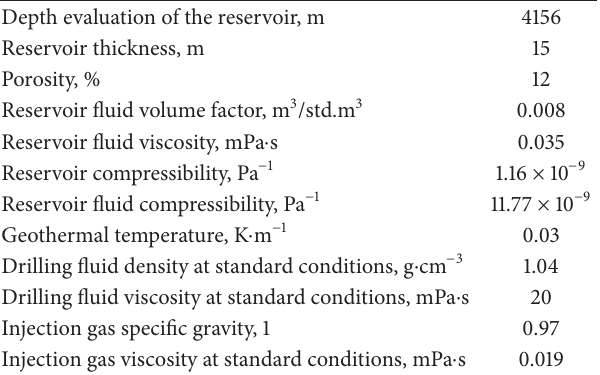
Table 1: Basic parameters for reservoir and drilling fluid used in reservoir characterization.